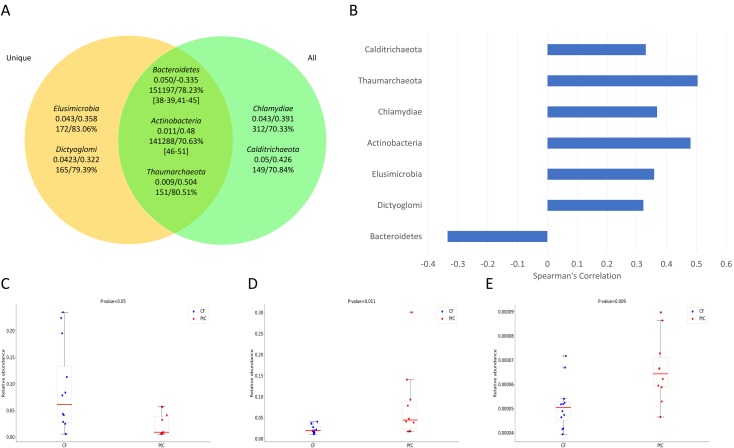
Significant phyla from unique reads only and all mapped reads, respectively.A. Seven significant phyla identified. The two numbers below a phylum name are the Mann-Whitney p-values, the Spearman’s correlations of the read abundances with the colitis severity. The next row provides the average number of reads mapped to each of the 22 samples and the percentage of unique reads among all mapped reads for the phylum. The third row below a phylum name gives the references that may support the colitis-relatedness of this phylum and its lower taxa. B. The Spearman’s correlation for seven phyla. C-E: the scatter plot of the relative read abundances in Bacteroidetes, Actinobacteria, and Thaumarchaeota, respectively.